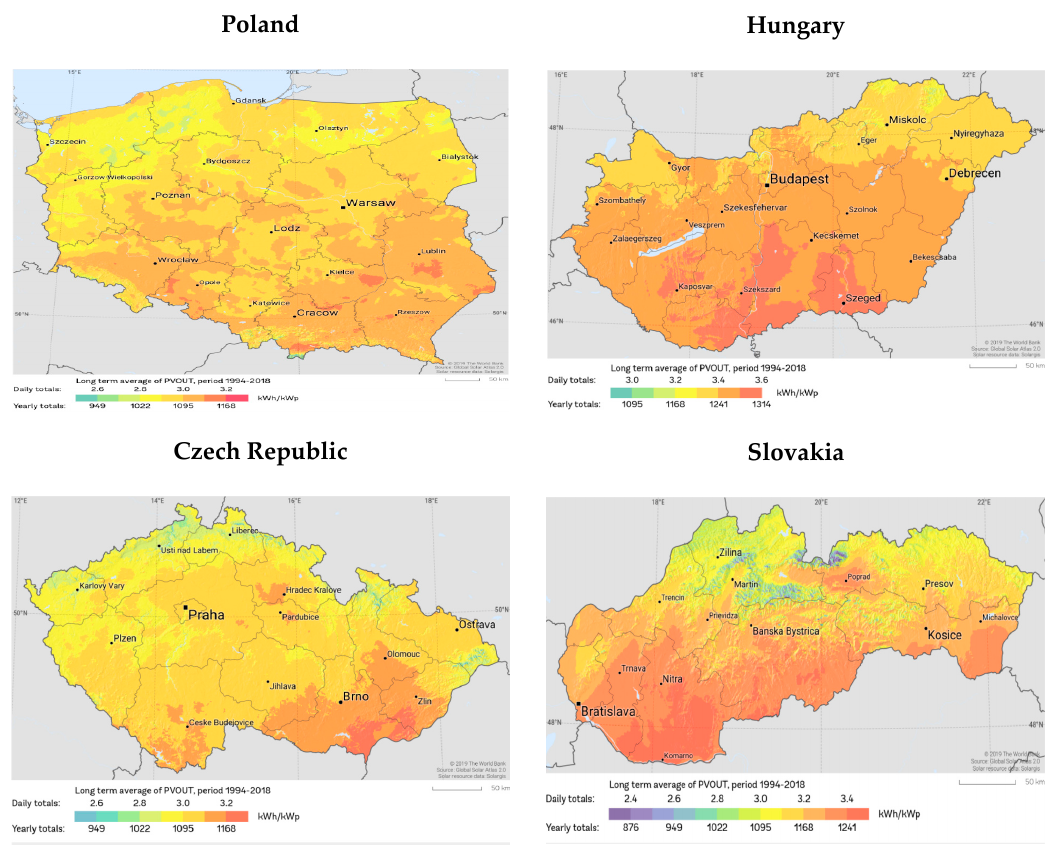
Figure 1. The photovoltaic power potentials of the V4 countries [67].